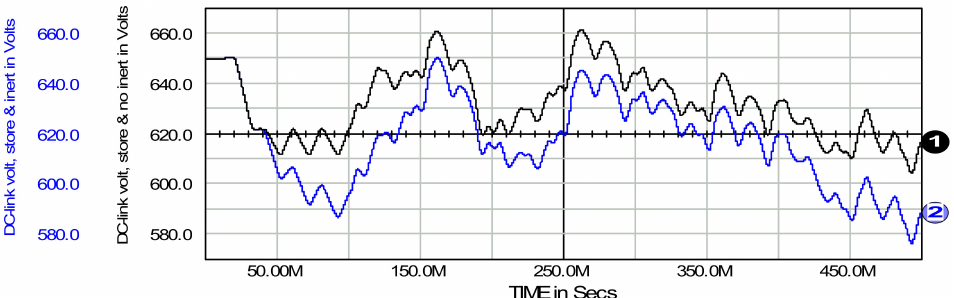
Figure 18. AC side source phase A current for store mode without inertia: waveforms 1, and for Scheme 2. Y scale for currents is 10A/div.